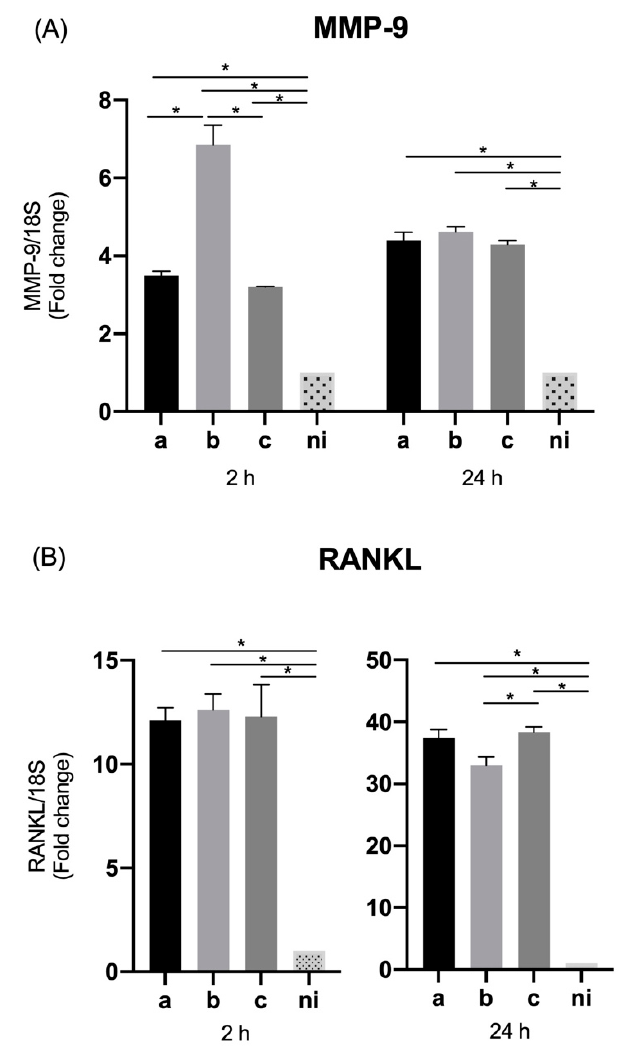
Figure 6. Molecules associated with tissue destruction mRNA expression by A. actinomycetemcomitans -induced THP-1 human macrophages (ATCC ® TIB-202™). Expression in macrophage cells infected at a MOI = 10 2 with strains ATCC ® 43717 TM (serotype a), ATCC ® 43718 TM (serotype b), and ATCC ® 43719 TM (serotype c), 2 and 24 h after infection. For relative expression, mRNA expression in non-infected (ni) macrophages was considered as 1, as a reference for fold-change in expression using 18S rRNA expression levels as a normalizing endogenous control. Data are represented as fold-change means and standard deviation of three independent experiments performed in duplicate. ( A ) MMP-9. ( B ) RANKL. Asterisks were used to indicate a value of p considered statistically significant (* p < 0.05). For its part, RANKL was significantly overexpressed in response to the 3 bacteria studied compared to the non-infected condition, serotype a ( p = 0.0015), b ( p = 0.0028), and